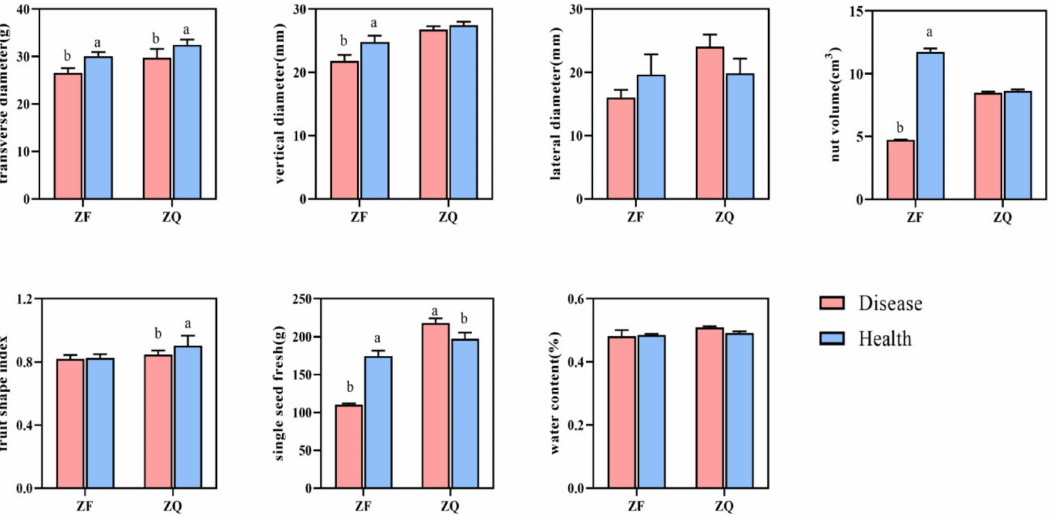
Figure 3. Changes in nut phenotypic traits in healthy and diseased chestnut trees. The significance of difference was labeled as ‘a’ and ‘b’ between healthy and diseased